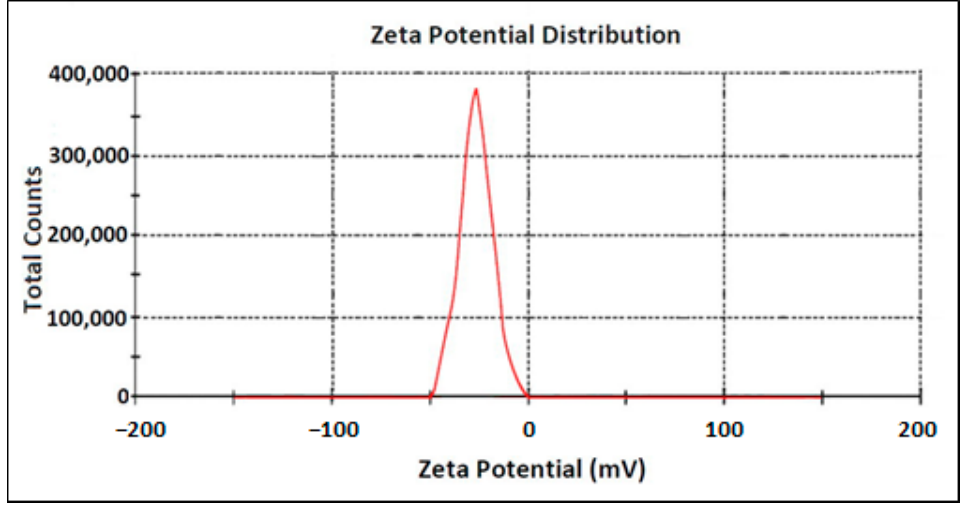
Figure 4. The zeta potential of the AgNPs phytofabricated by using the O. persica leaf extract.